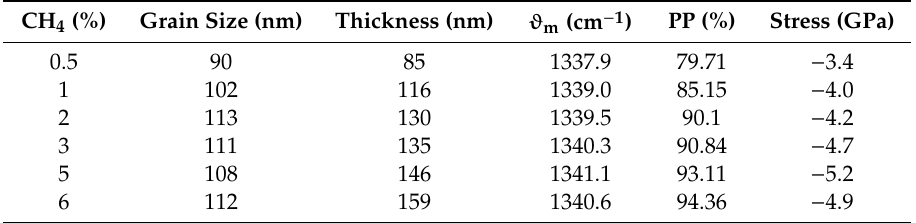
Table 1. Grain size, thickness, Raman peak, phase purity, and stress of diamond at di ff erent CH 4